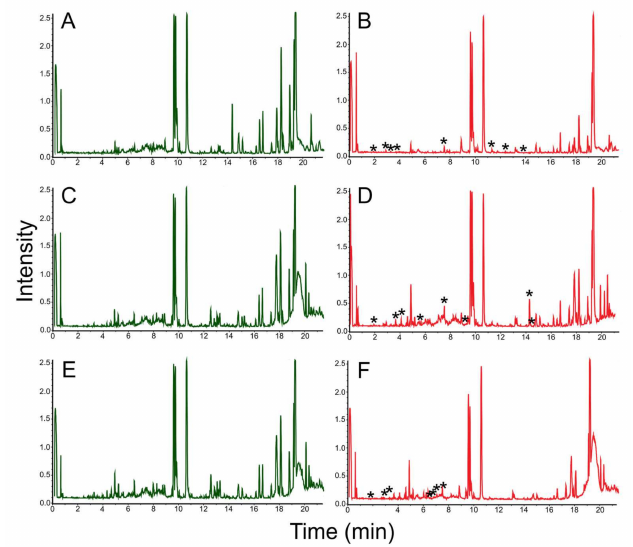
Figure 8. Chromatograms of natural products extracted from MM media with birch sawdust added (left column, control parameters) and MM (left column, experimental parameters) where Streptomyces sp. LPB2019K190-4 was cultivated: ( A ) MM media without sawdust (control); ( B ) Streptomyces sp. LPB2019K190-4 cultivated on MM media without sawdust (control); ( C ) MM media with a relatively low content of birch sawdust (control); ( D ) Streptomyces sp. LPB2019K190-4 cultivated on MM media with a relatively low content of birch sawdust ( E ) MM media with a relatively high content of birch sawdust (control); ( F ) Streptomyces sp. LPB2019K190-4 cultivated on MM media with a relatively high content of birch sawdust. *-asterisks indicate the differences (new peaks) between MS-spectrums of control and experimental samples.